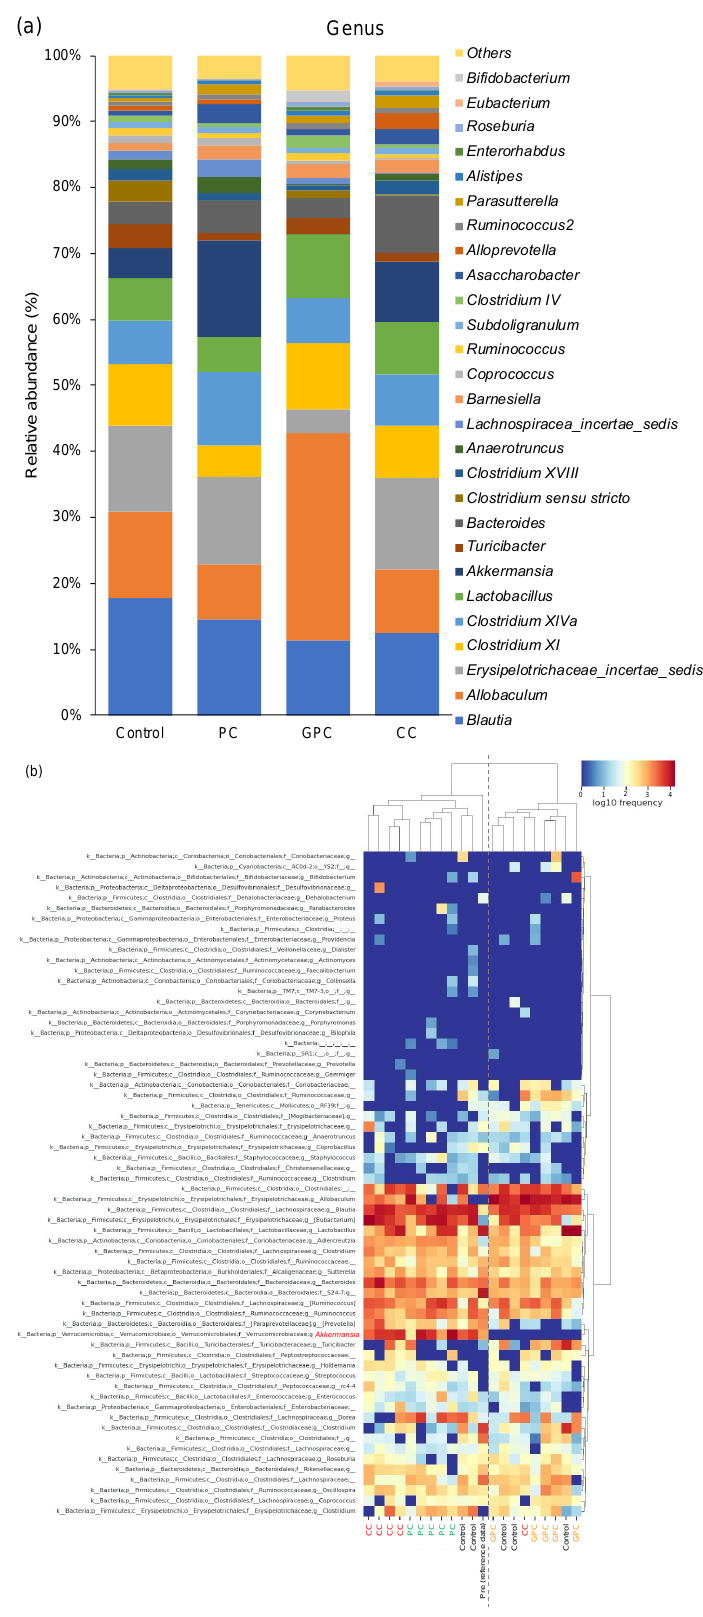
Figure 4. ( a ) Effects of dietary choline compounds on relative abundance of fecal microbiota at the genus level. The 27 dominant microbes with relative mean abundances of >0.5% are shown. Microbes with relative mean abundances of <0.5% are summed into “others.” ( b ) Heatmap and hierarchical clustering dendrogram of gut microbiota composition at the genus levels.